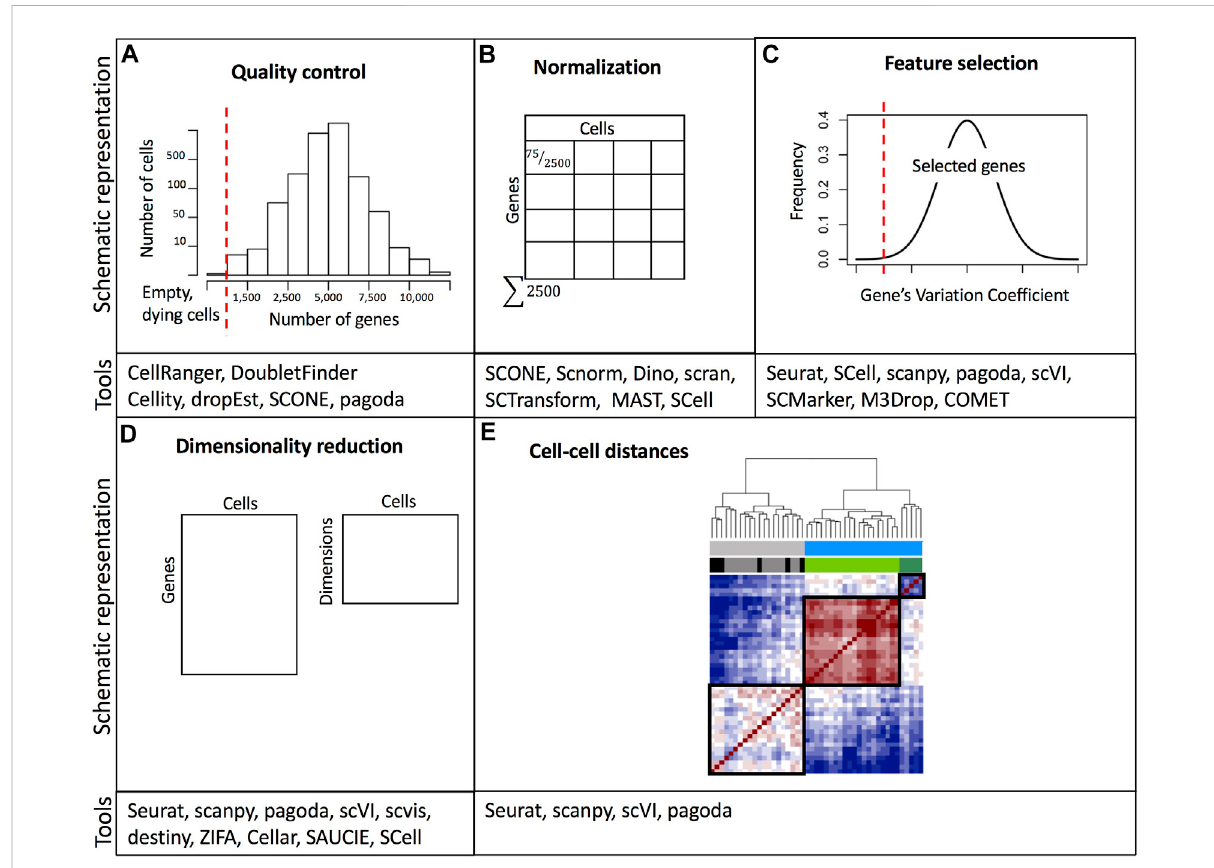
FIGURE 2 Overview of common data processing steps with examples of relevant software tools. (A) Example of threshold assignment for the minimum number of genes per cell as part of the quality control. Cells with a small number of detected genes are likely empty wells/droplets or non-viable cells. (B) Normalization of gene expression based on cell depth. (C) Filtering out genes with low variability is part of the feature selection. (D) Dimensionality reduction. (E) Calculation of a distance matrix based on cell-cell gene expression similarity metrics. A comprehensive list of software packages for single-cell data analysis is included in https://github.com/seandavi/awesome-single-cell. References to example tools are listed in Supplementary Table